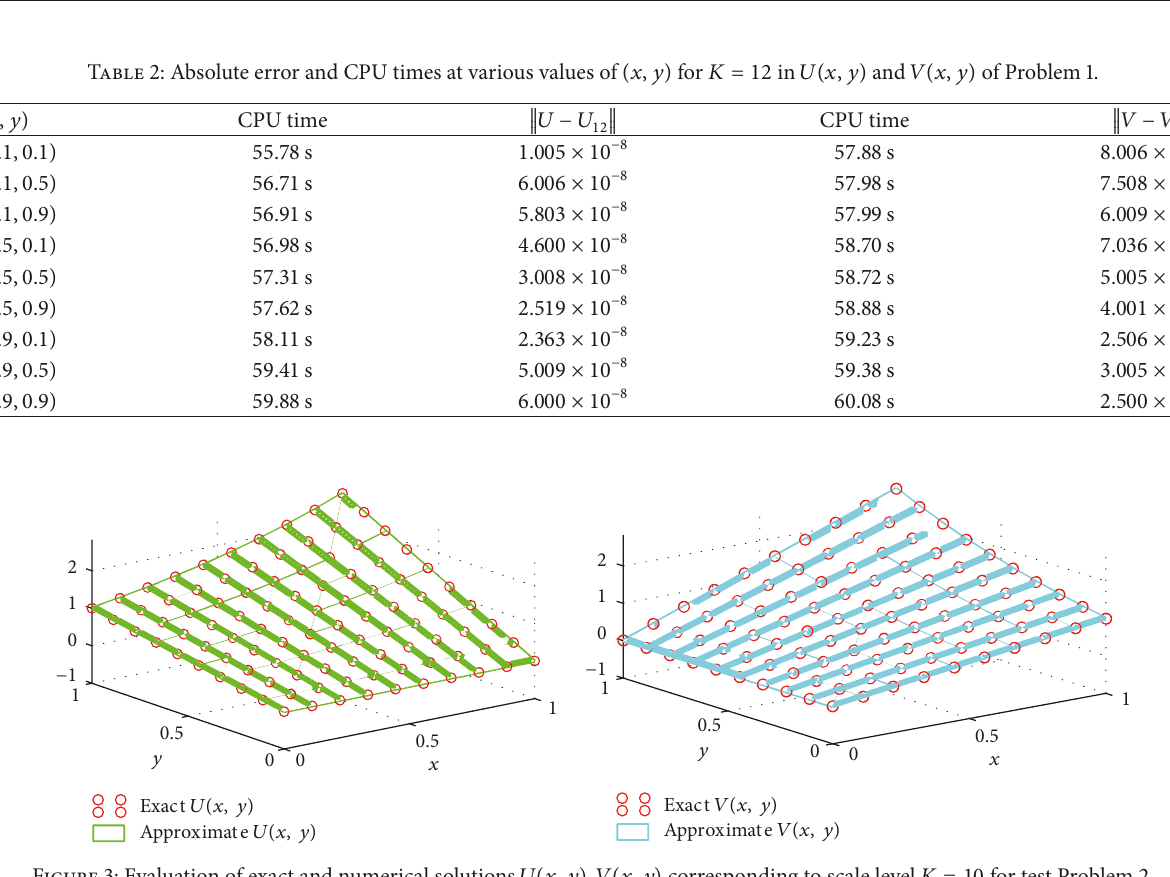
Figure 3: Evaluation of exact and numerical solutions 𝑈(𝑥, 𝑦) , 𝑉(𝑥,𝑦) corresponding to scale level 𝐾 = 10 for test Problem